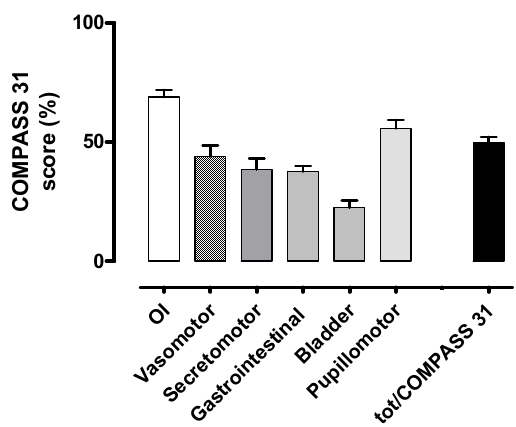
Figure 1. Baseline autonomic symptom assessment by COMPASS 31 questionnaire. OI indicates orthostatic intolerance domain; Vasomotor, vasomotor function domain; Secretomotor, secretomotor function domain; Gastrointestinal, gastrointestinal function domain; Bladder, bladder function domain; Pupillomotor, pupillomotor function domain; tot/COMPASS 31, total COMPASS 31 score. The scores are here represented as a percentage of the maximum value obtainable in each domain.